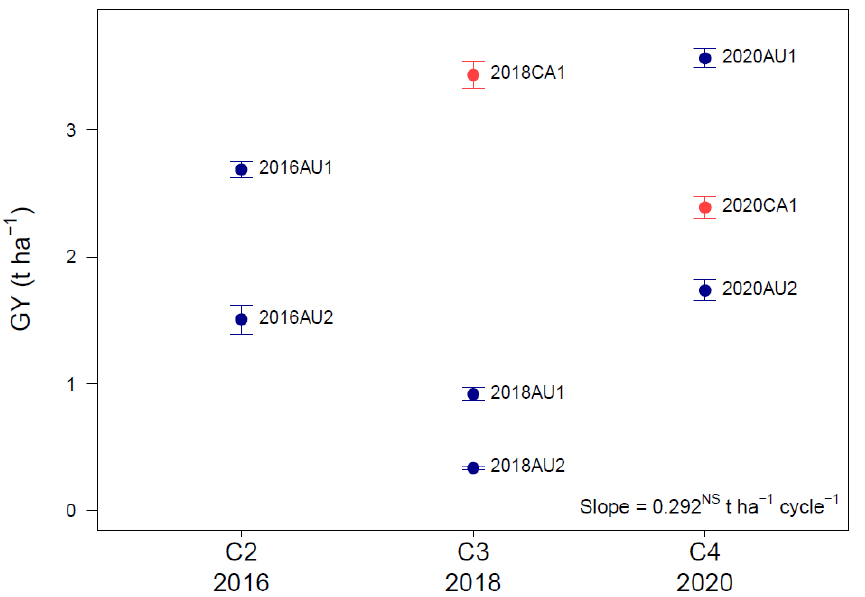
Figure 4. Lack of an environmental trend in site predicted grain yield (GY, t ha − 1 ) ± standard error in field trials in Australia and Canada across cycles 2 (C2 2016), 3 (C3 2018) and 4 (C4 2020) from the optimum MMM-FA model of the genotype by environment effects (see Table 2). The slope of the linear regression of the predicted site mean GY across cycles was not significant (NS). For a description of trial codes, see Table 1.